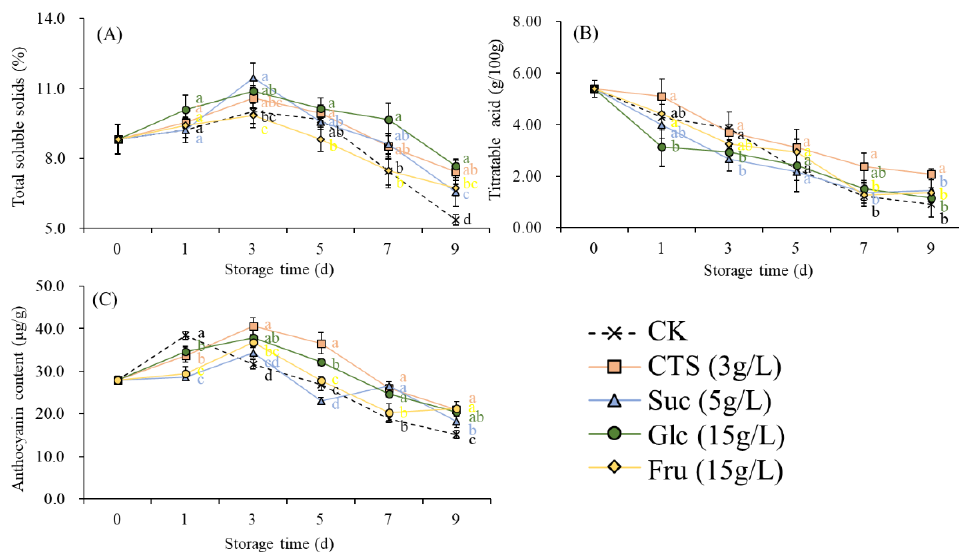
Figure 6. Effects of chitosan (3 g/L), sucrose (5 g/L), glucose (15 g/L), and fructose (15 g/L) on the ( A ) titratable acid, ( B ) total soluble solids, and ( C ) total anthocyanin content of strawberry fruits stored at 15 ± 2 °C for 9 d. CK represents that strawberry fruits were immersed with water before storage. Data are mean of three replicates. Different letters in the same storage time indicate a significant difference (Tukey’s HSD test, p < 0.05). CTS, chitosan; Suc, sucrose; Glc, glucose; Fru, fructose.